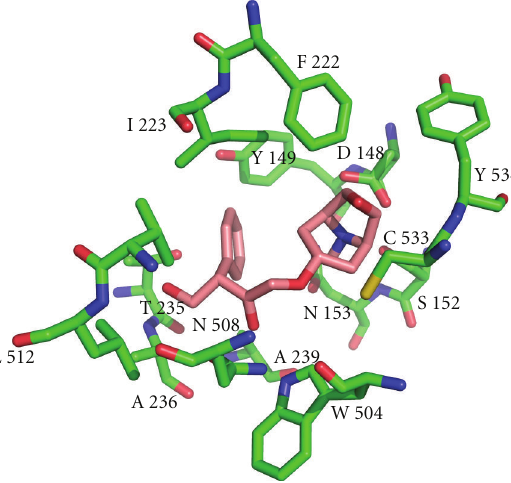
Figure 5: Binding pocket of the M3R: D148 3 . 32 , S152 3 . 36 , N153 3 . 37 , F222(ECL2), I223(ECL2), T235 5 . 42 , A236 5 . 43 , A239 5 . 46 , W504 6 . 48 ,